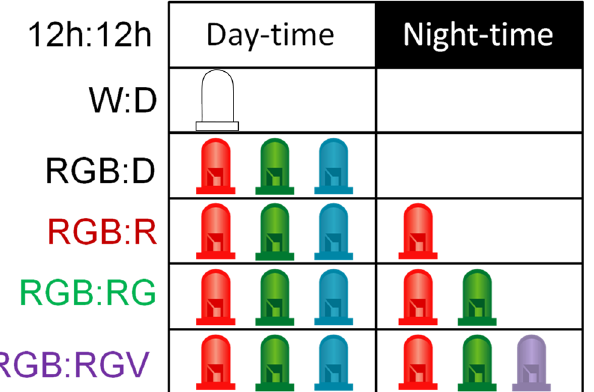
Figure 10. Experimental design. Animals (27 degus and 12 rats) were exposed to white or a combined red- green-blue LEDs (RGB) illumination for 12 h during daytime. At night, they were subjected to different conditions: i) darkness; ii) red light (R); iii) combined red-green LED (RG) lights; and iv) combined red-green- violet LED (RGV)